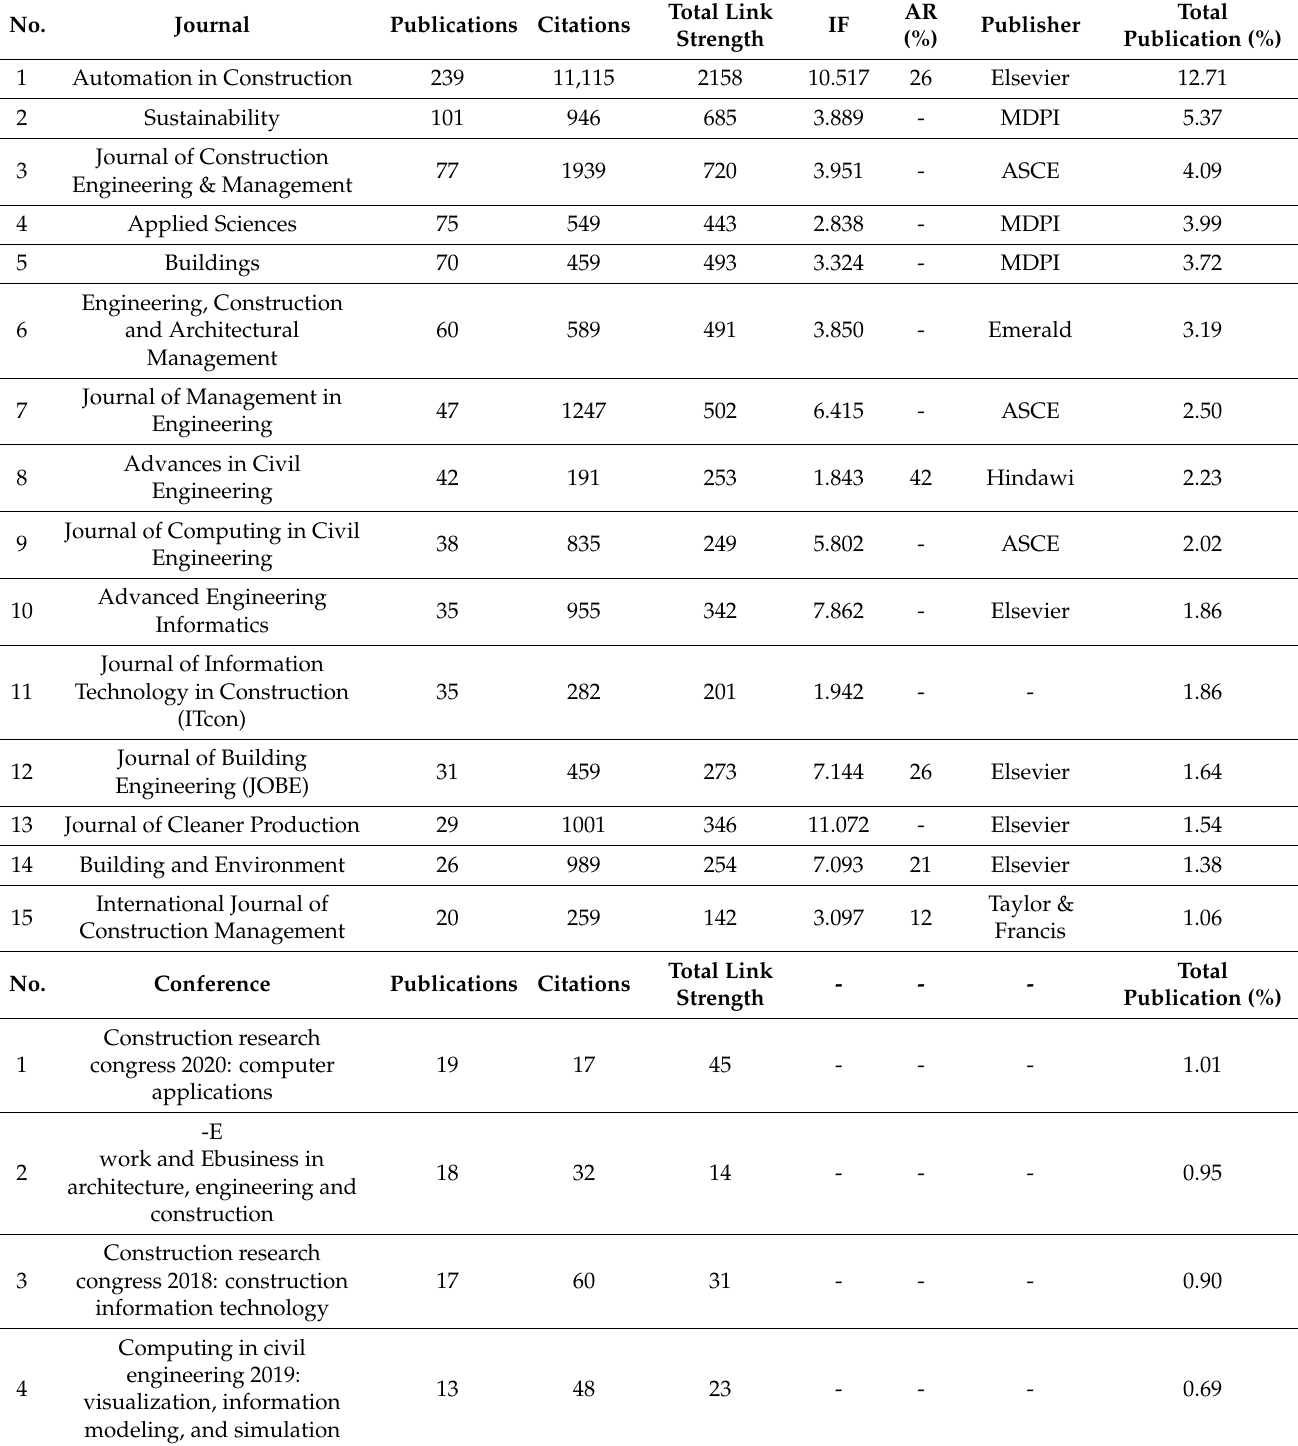
Table 6. Top journals and conferences in the field of BIM, IoT, and DT in